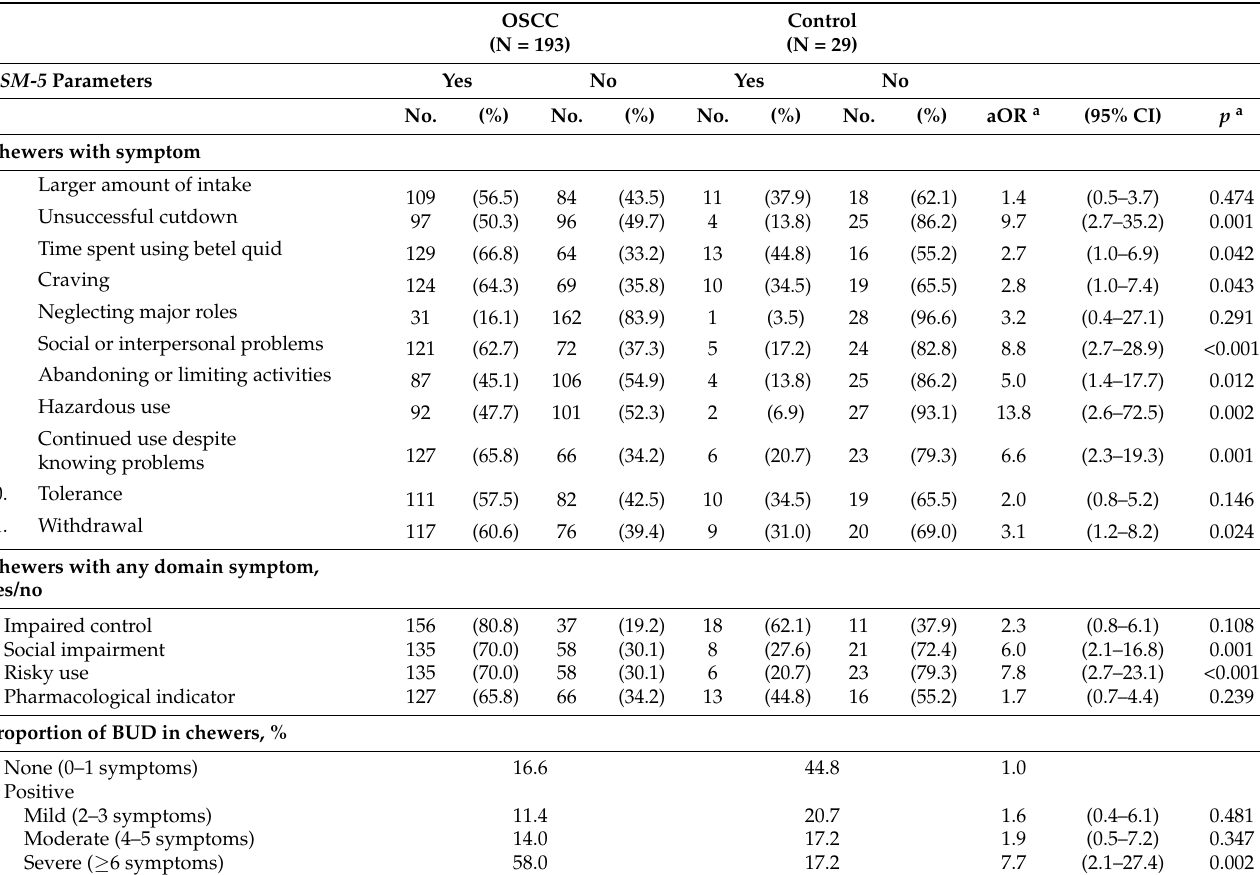
Table 5. Adjusted odds ratios of oral squamous cell carcinoma associated with DSM - 5 symptoms among betel quid